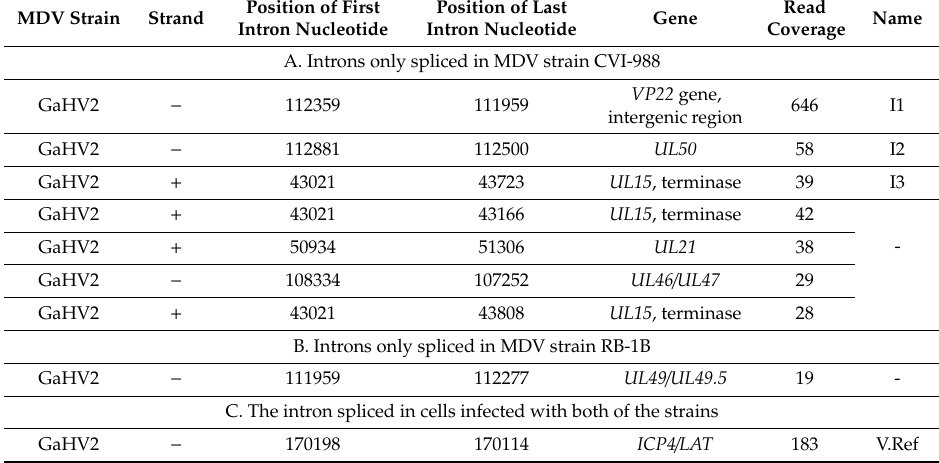
Table 3. List of introns that are (A) spliced exclusively in MDV strain CVI-988, or (B) spliced exclusively in MDV strain RB-1B. (C) The intron, which was chosen as the viral reference (V.Ref) in ICP4 / LAT . To make splicing events occurring in di ff erent MDV strains comparable, all introns are listed in terms of coordinates on the basis of the genomic sequence of MDV reference strain MD5 / GaHV2 (NCBI accession NC_002229.3). Mapping the introns occurring in the RB-1B / CVI-988 transcriptomes to the MD5 genome was possible thanks to the extremely high sequence similarity ( > 99%) shared by MD5, RB-1B, and CVI-988. A full table with intron coordinates to all the three strains is provided in Table